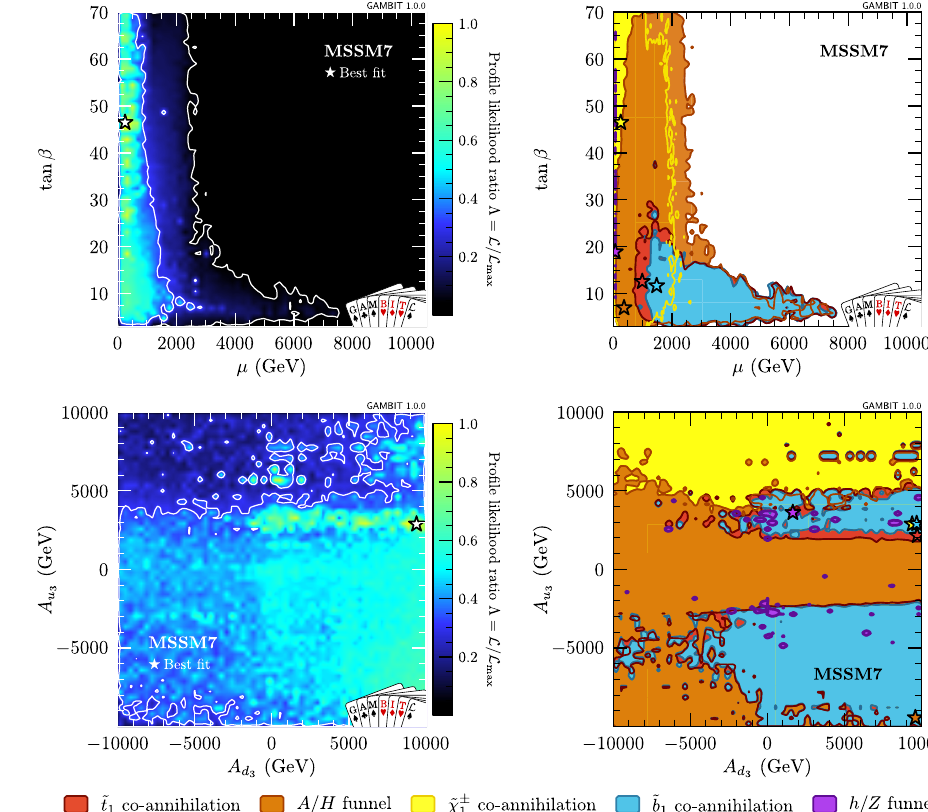
Fig. 5 Left: joint profile likelihoods in μ –tan β (top) and A u – A d planes. Right: 3 3 coloured regions indicating in which parts of the 2 σ best-fit region different co-annihilation and funnel mechanisms contribute to the relic density. The best-fit point in each region is indicated by a star with the corresponding colour. In the bottom right plot the yellow chargino co-annihilation region covers the entire plane and the orange A / H funnel region spans the entire plane below ∼ 5 A u 3